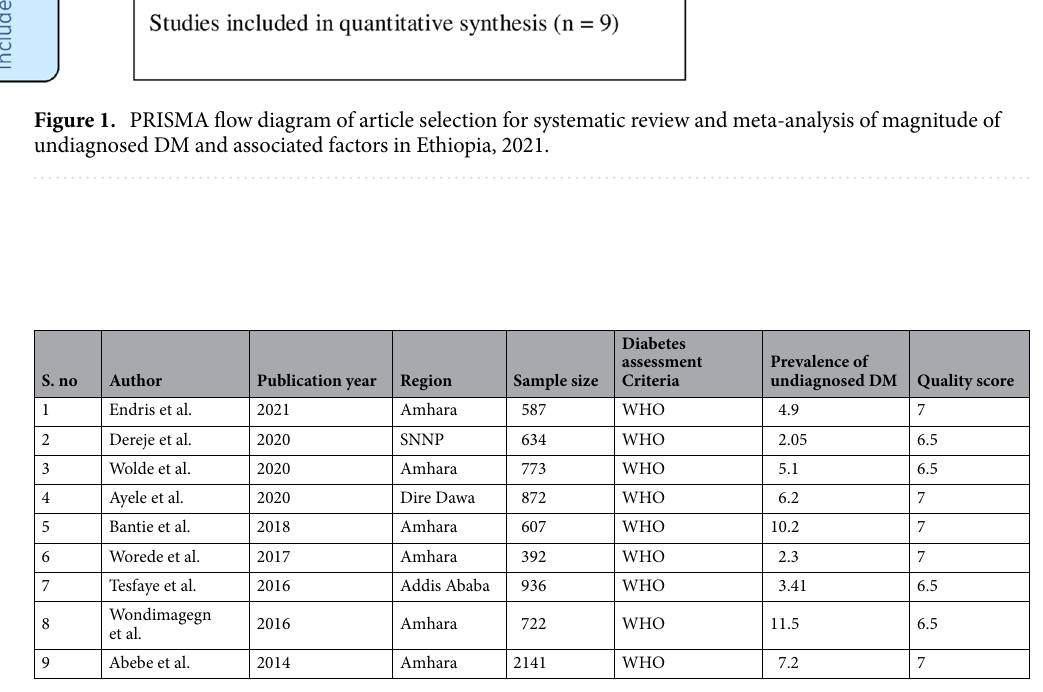
Table 2. Characteristics of the studies included for systematic review and meta-analysis on prevalence and associated factors of Undiagnosed DM in Ethiopia, 2021.